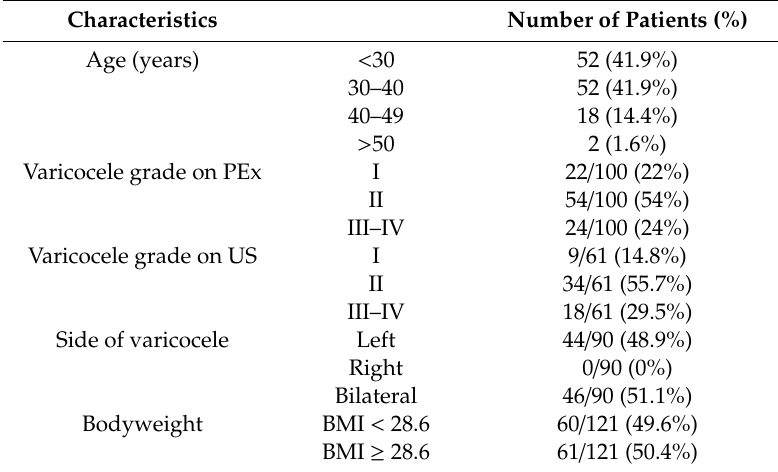
Table 1. Characteristics of patients receiving varicocelectomy.